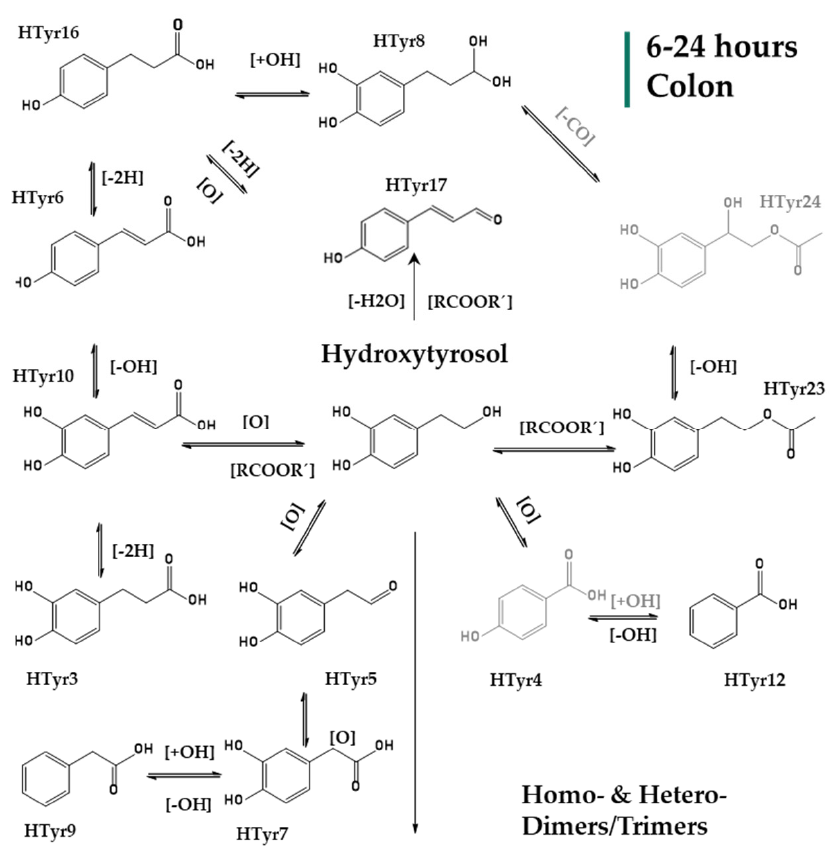
Figure 4. Suggested metabolism pathway of HTyr exposed for 6 to 24 h at colonic conditions (small intestine retentate, fecal slurry, pH: 5.8, anaerobic conditions, T = 37 °C). All metabolites detected (black color) or eliminated (grey color) at the last 18 h of colonic metabolism.